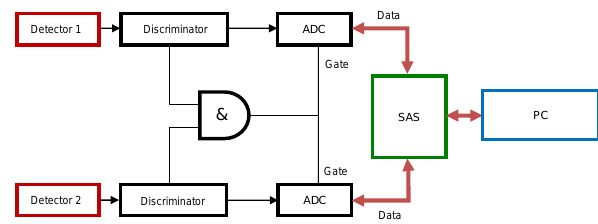
Figure 8. Hardware coincidence detector block diagram. The AND gate is the core of the circuit; its output becomes active when both inputs are activated. Here, the SAS only acquires and records data. It does not work as a coincidence system. The PC is only used to launch and stop the SAS